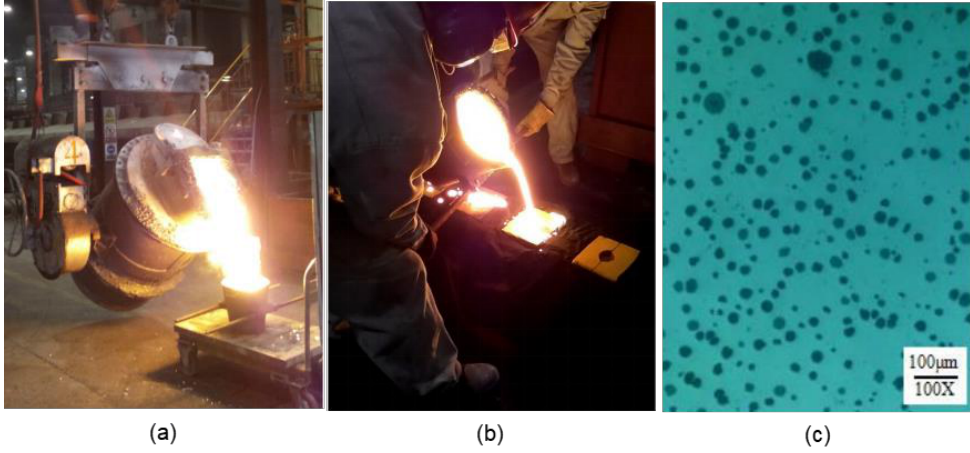
Figure 2. Transition of the molten alloy and the pouring process of prototypes: ( a ) Molten alloy was transferred to a two-man ladle through a transfer ladle; ( b ) Prototypes were poured by a two-man ladle; ( c ) Morphology of graphite spheres in ductile iron after solidification, spheroidization rate: 91%. Table 2. Experimental scheme of manufacturing the prototype castings. No. Test No. Model Type Pouring Temperature ( ◦